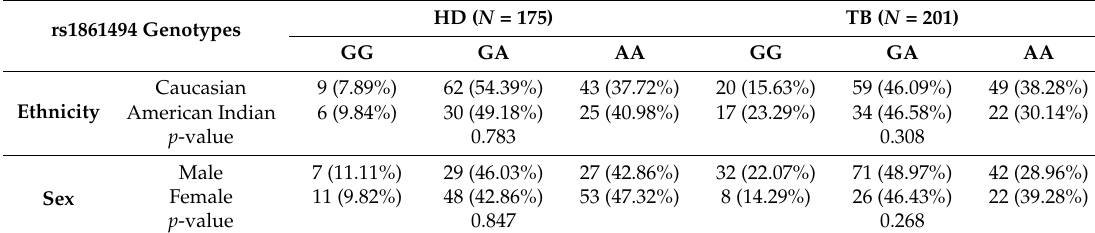
Table 2. Genotypic frequencies distribution of the Interferon gamma ( IFNG ) rs1861494 SNP in HD and TB populations stratified by ethnicity and